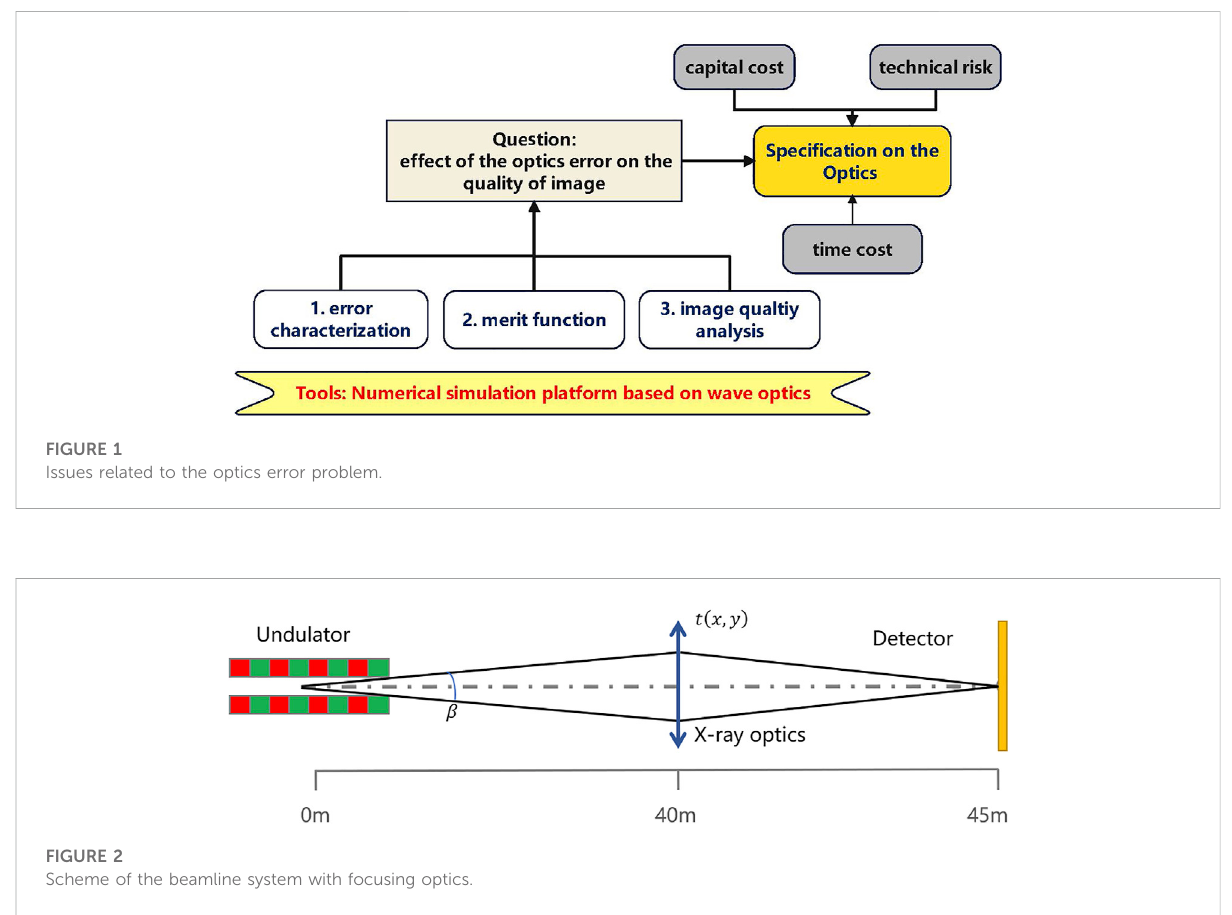
beamline simulation. Replacing numerical calculations with local data access also reduces the requirement on the large memory.